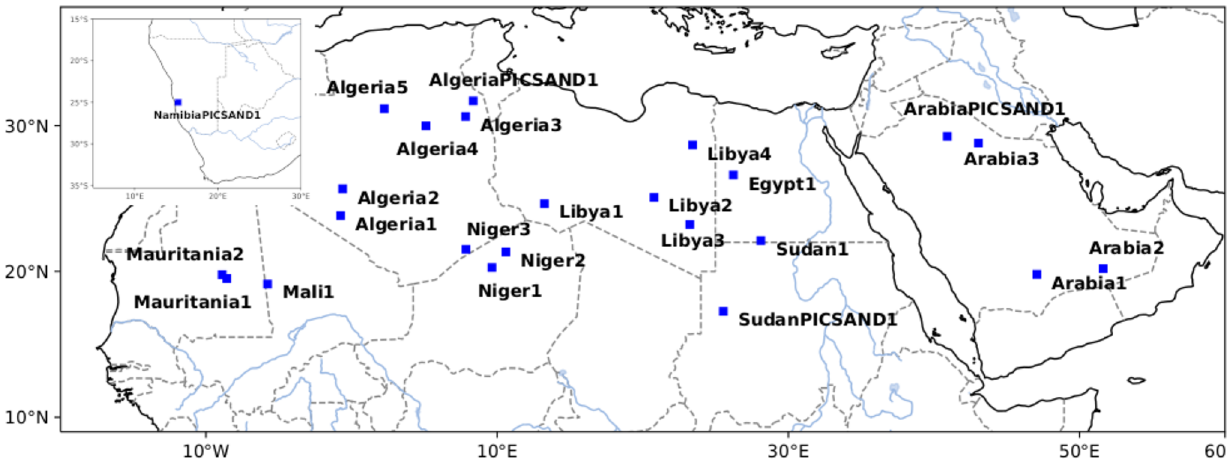
Figure 1. Location of Saharan and Arabian PICS. The PICS in the Namib desert are shown as an